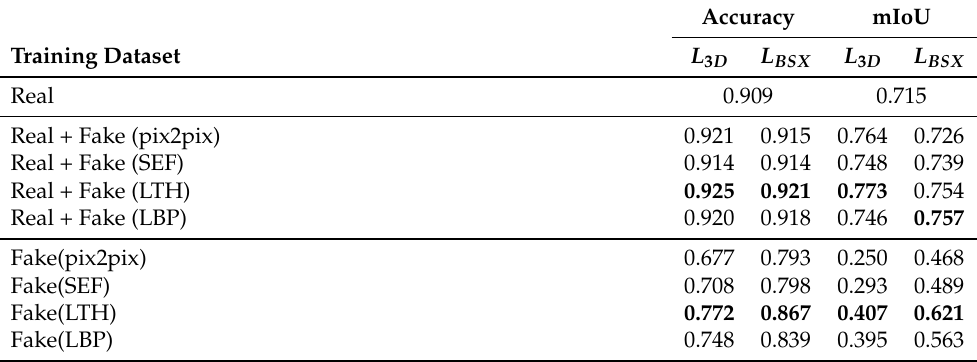
Table 2. Effect of fake images on the segmentation performance.